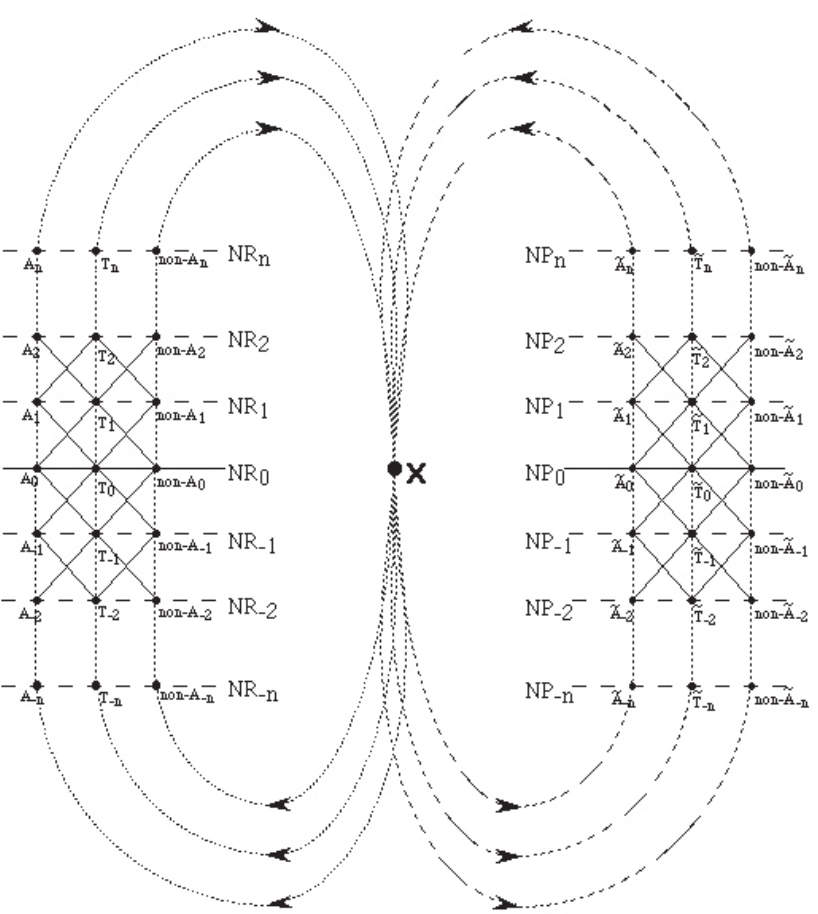
Figure 1: The transdisciplinary Object, the transdisciplinary subject and Interaction